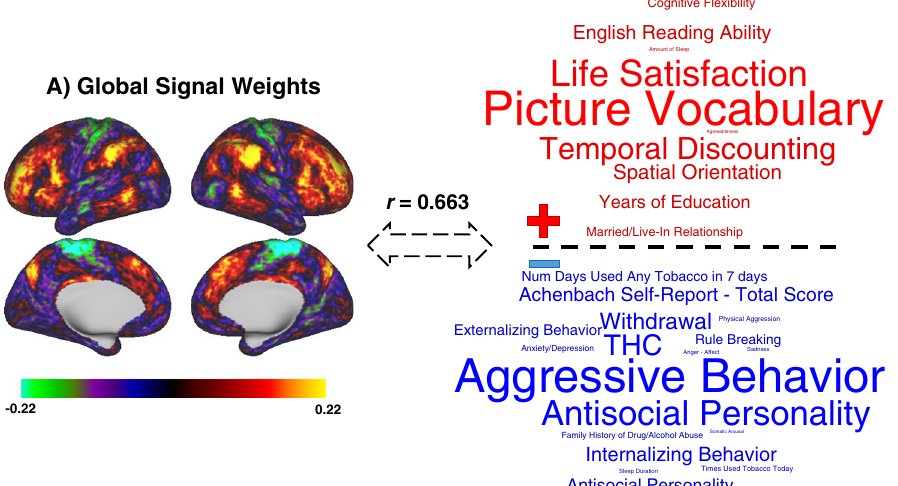
Figure 3. Individual differences in behavior associated with the global signal. ( A ) CCA weights of each vertex on the first canonical variate pair. Strong positive weights are observed in the frontoparietal and salience networks, and strong negative weights are observed in the motor cortex. ( B ) Top 20% positive (blue) and negative (red) behavioral variable CCA weights displayed in a word cloud. The size of the text in the word cloud is proportional to the absolute value of that variable’s CCA weight.